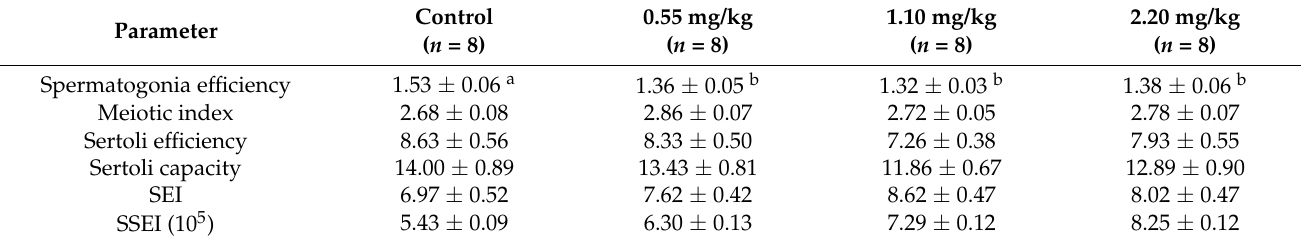
Table 8. The spermatogonia efficiency, meiotic index, Sertoli efficiency, Sertoli capacity, the Sertoli cell index (SEI) and